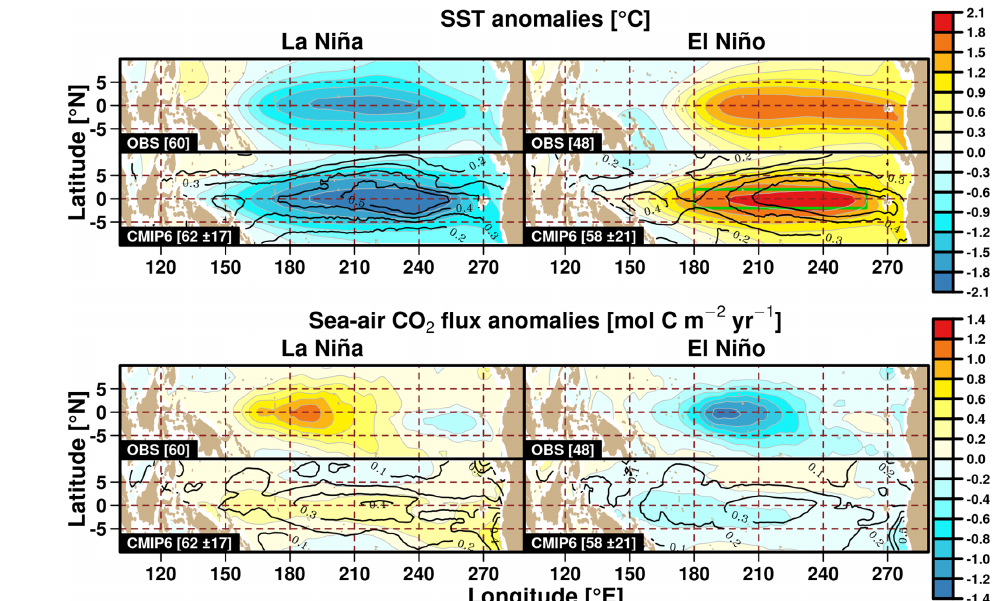
Figure 2. Observed JRA-55 and mean CMIP6 SST (in ◦ C, top) and observed MPI-SOM-FFN and mean CMIP6 sea–air CO 2 fluxes (in molCm − 2 yr − 1 , bottom), shown as average anomalies over the 1985–2014 contemporary period for the La Niña (left) and El Niño (right) regimes. The number of months in each regime for the observations and the mean number with 1 standard deviation for the CMIP6 ensemble are both given in square brackets. Black contours represent the CMIP6 inter-model ensemble anomaly standard deviation during each ENSO phase. The green box in the lower-right SST panel illustrates the EP (equatorial Pacific)